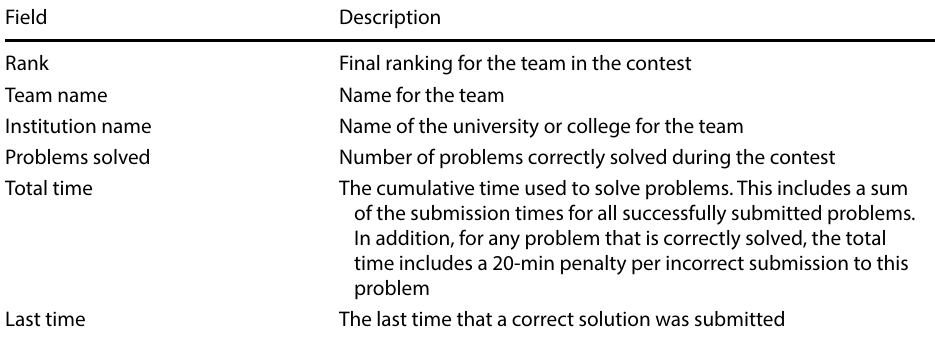
Table 1 Attributes in ICPC results